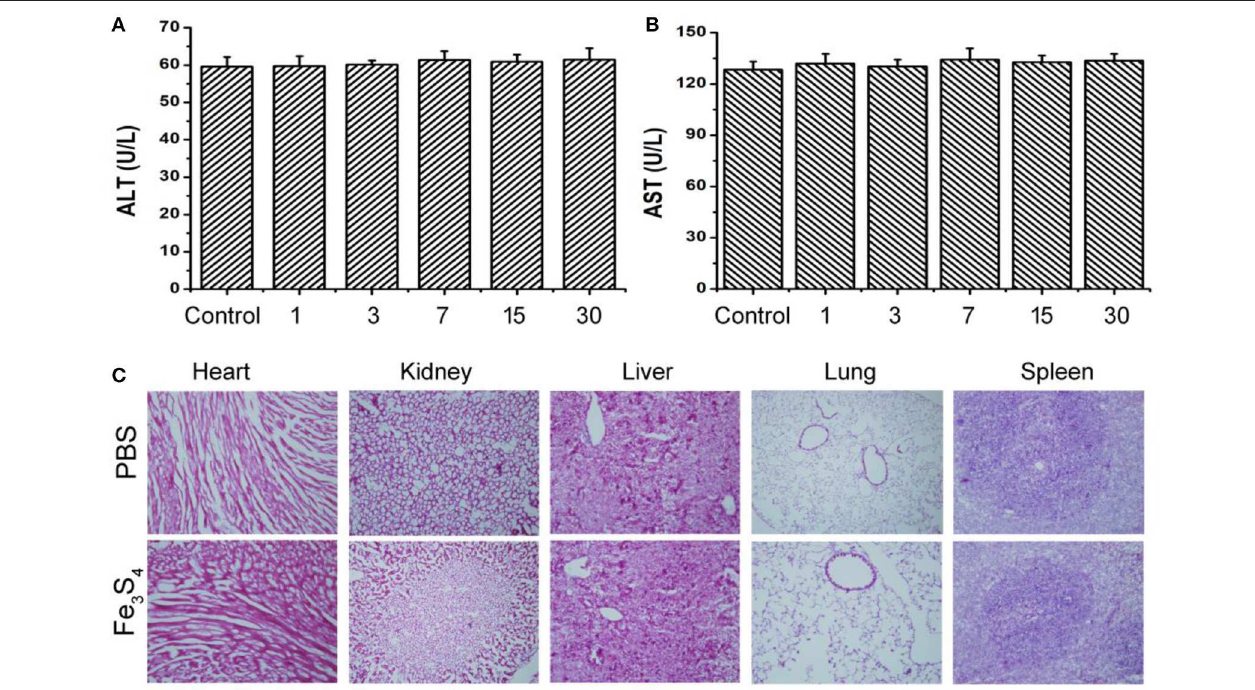
FIGURE 6 | Blood bioanalysis of mice in control group and Fe 3 S 4 group at different time points (1, 3, 7, 15, and 30 days), including (A) alanine aminotransferase (ALT) and (B) aspartate aminotransferase (AST). (C) Hematoxylin and Eosin stained tissue sections from the mice to monitor the histological changes in heart, kidney, liver, lung, and spleen of the mice 1 month after a single intravenous injection of the Fe 3 S 4 nanoparticle’ solution. Scale bar: 100 µ m.